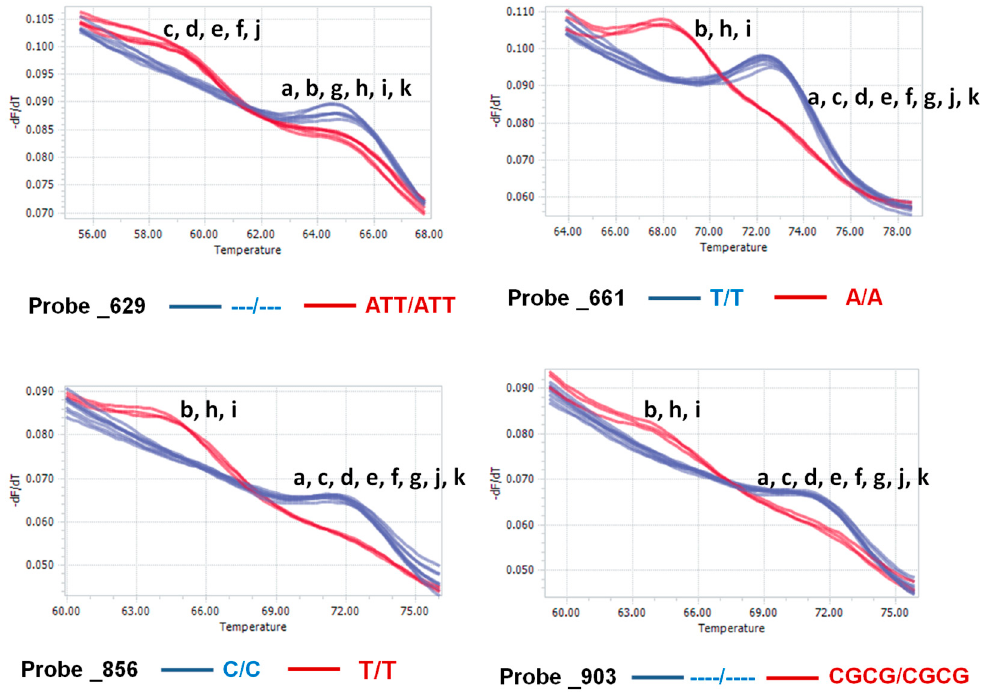
Figure 7. Variation due to polymorphism between Korean P. brassicae isolates. The melting temperatures are shown for probes (single-nucleotide and oligonucleotide polymorphism and InDel) after high-resolution melting analysis in a Roche light cycler. a, Gangneung1; b, Yeoncheon; c, Daejon; d, Haenam2; e, Seosan; f, Pyeongchang; g, Gangneung2; h, Haenam1; i, Hoengseong; j, Geumsan; and k, Goesan.